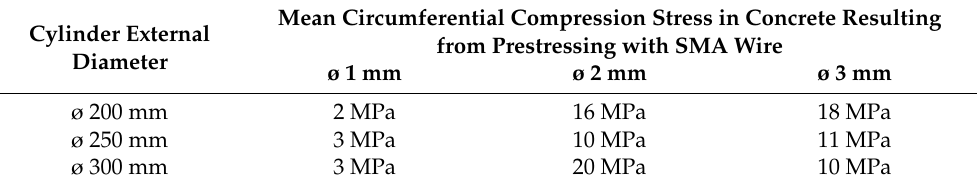
Table 6. Mean values of circumferential compression stress in concrete resulting from prestressing with SMA wire at the residual state σ c,SMA .